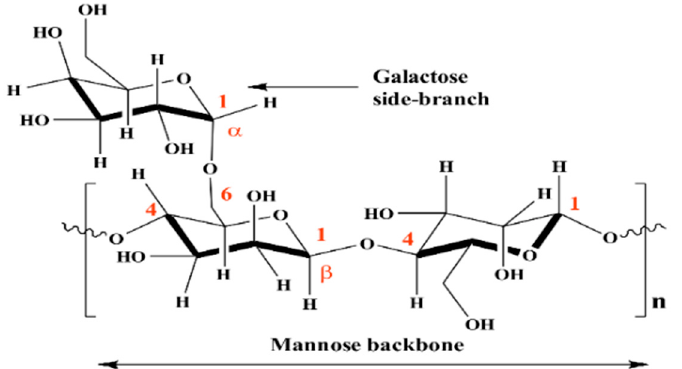
Figure 1. Chemical structure of Guar gum (GG).